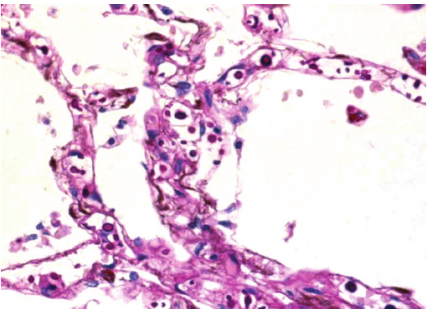
Figure 5: In patient with acquired immunodeficiency syndrome, a large number of yeast were observed in the pulmonary septal capillaries (periodic acid Schiff reaction, original magnification ×